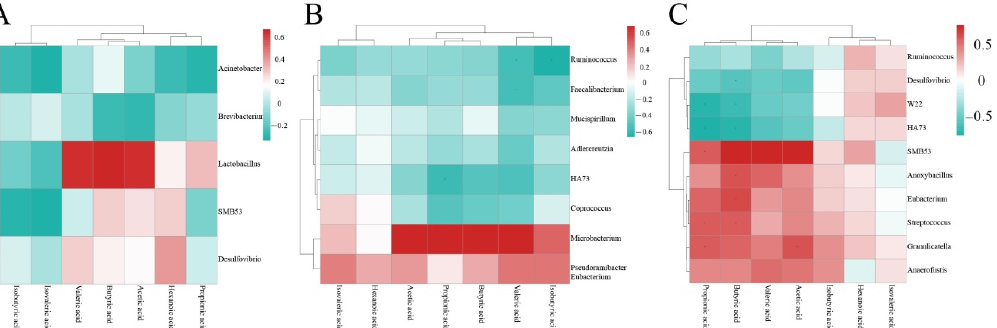
Figure 13. Heatmap of SCFAs and intestinal floras of chicken cecum contents of different groups. Note: ( A ) Cluster heatmap of SCFAs and intestinal floras in the normal control group and the model group; ( B ) Cluster heatmap of SCFAs and intestinal floras in the normal control group and the in ‐ tervention group of CASP; ( C ) Cluster heatmap of SCFAs and intestinal floras in the model group and the intervention group of CASP.